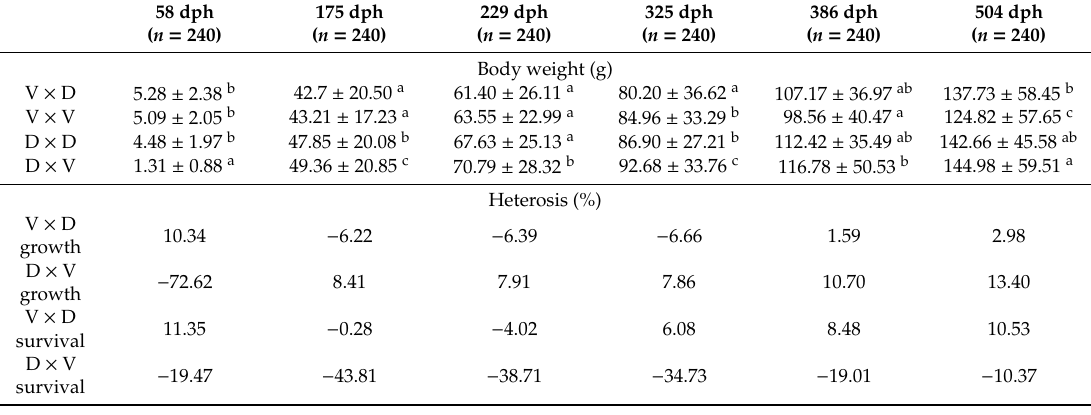
Table 4. Observed values of body weight (g mean ± SD) and average heterosis (%) of hybrid and purebred sterlet at selected days post-hatching (dph). Di ff erent superscripts within a column indicate significant di ff erences.